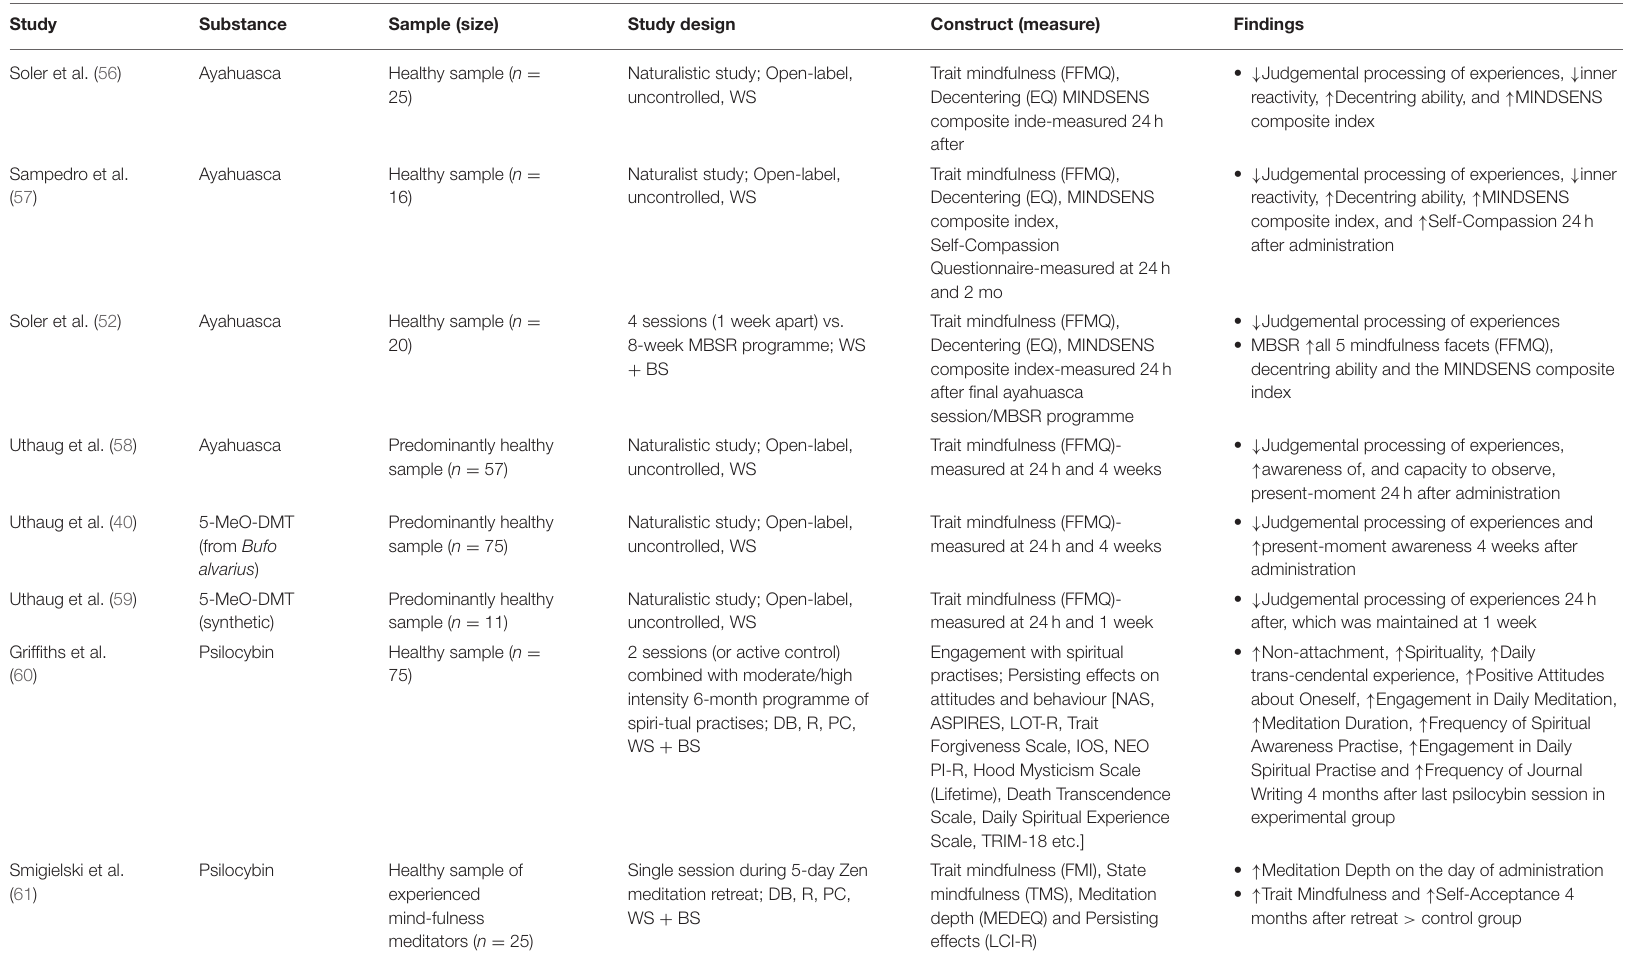
TABLE 2 | Summary of studies demonstrating enhanced mindfulness after psychedelic